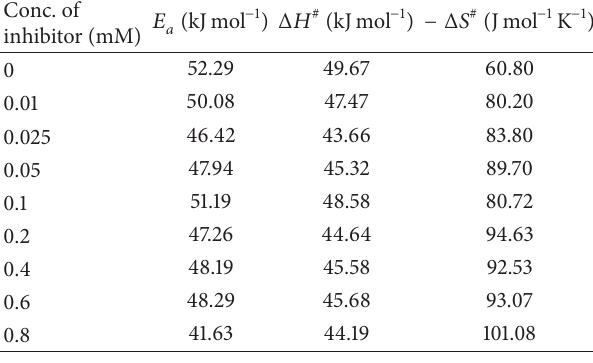
Table 2: Activation parameters for the corrosion of mild steel in 1M HCl acid containing different concentrations of HIBH. Conc. of